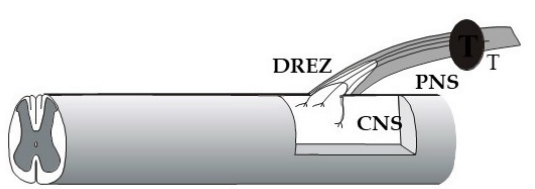
Figure 3. Scheme of experiment with human embryonic/fetal dorsal root ganglion (DRG) transplant (T) in the cavity of the extirpated native DRG of an adult rat recipient. Sensory axons from the trans- plant grow through the host DREZ and make synaptic contacts in the host spinal cord. For further information, see [152,153].